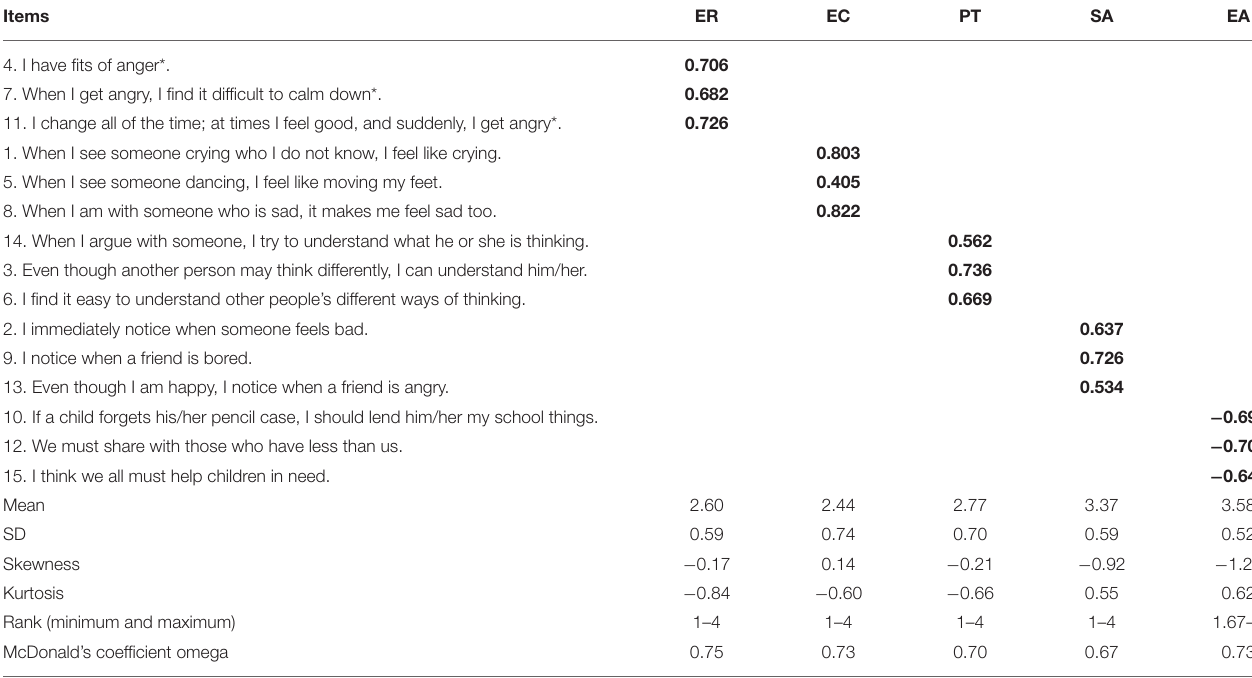
TABLE 2 | Results of the Principal ComponentAnalysis, Factor Matrix, and Oblimin Rotation.